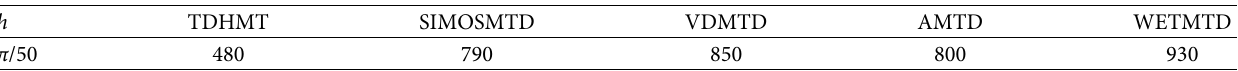
Table 12: Comparison of the NFE of TDHMT with the NFE of other existing methods, namely, SIMOSMTD, VDMTD, AMTD, and WETMTD for Example 2 at the end point.